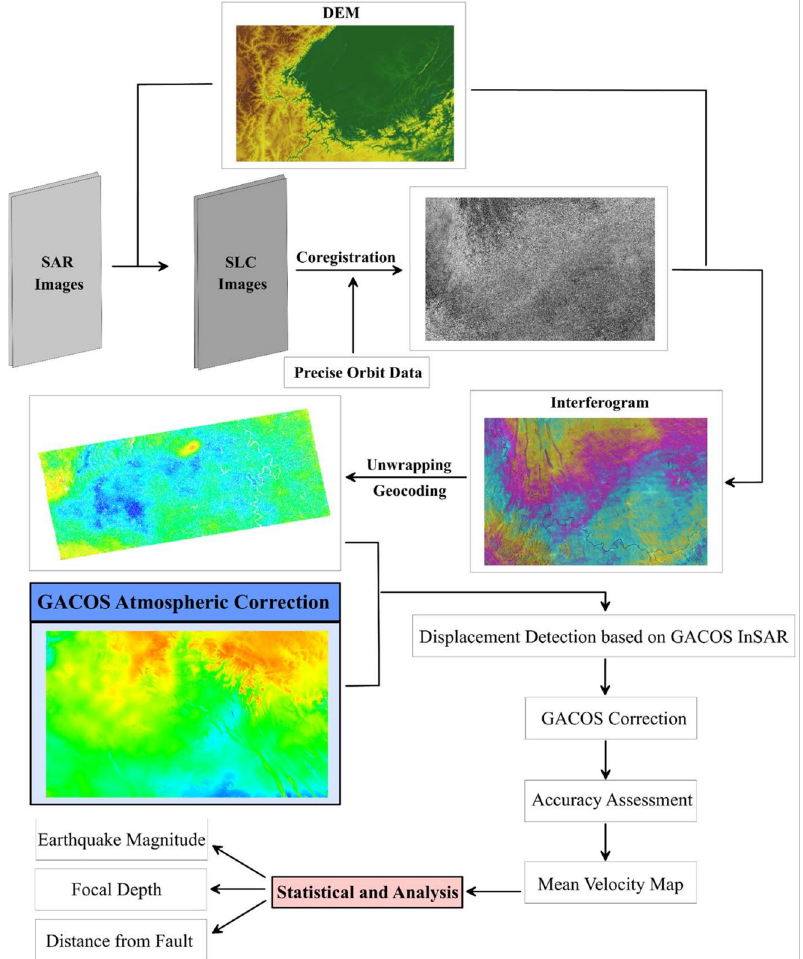
Figure 2. Flowchart of the